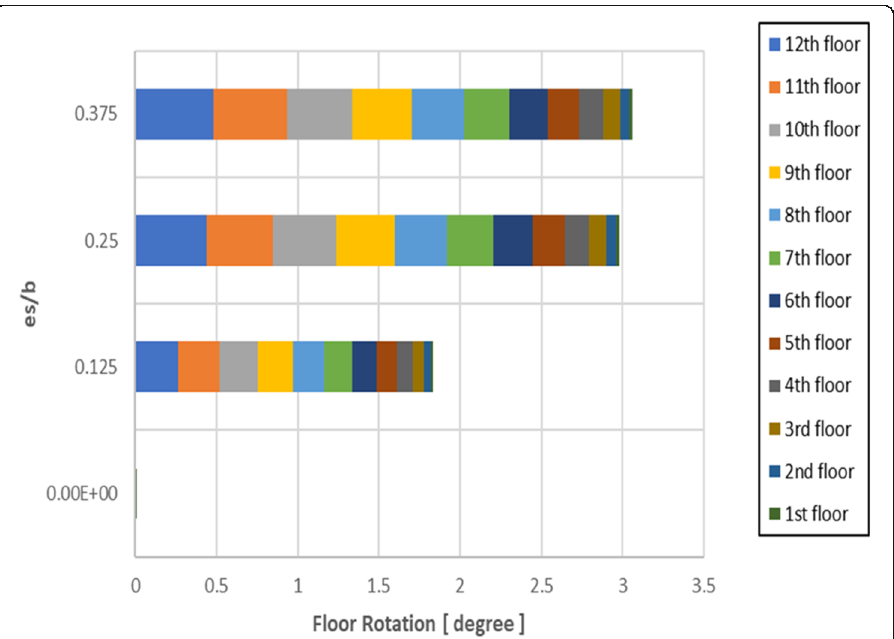
Fig. 23 Comparison of es / b — floor rotations for DS-1-1, DS-1-2, D1-1-3, and DS-1-4 (color should be used for this figure)